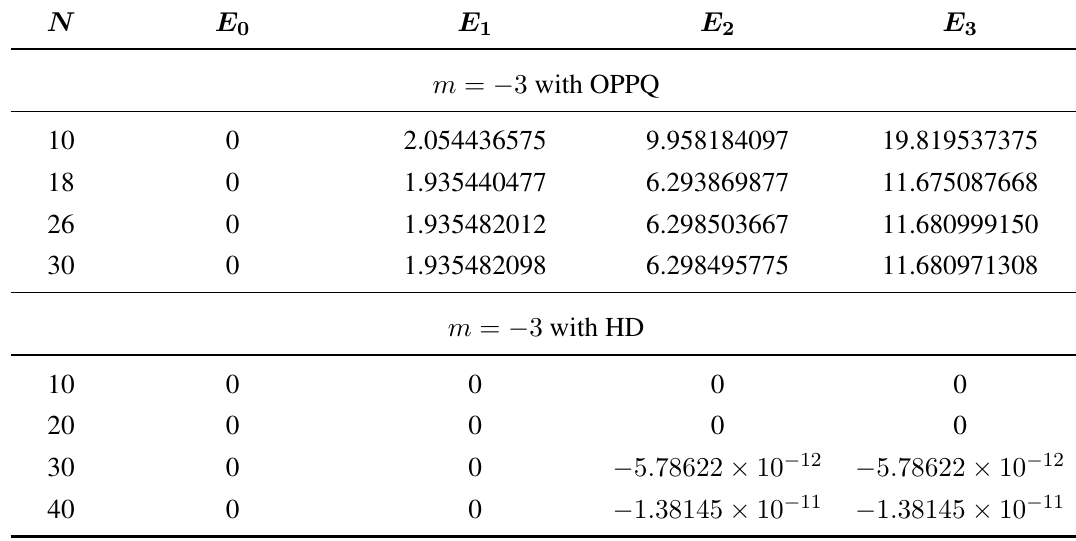
Table A2. Convergence for the four lowest energy levels using OPPQ and Hill determinant (HD) methods for V ( x ) = mx 2 + x 6 , using physical reference function R ( x ) = e − x 4 / 4